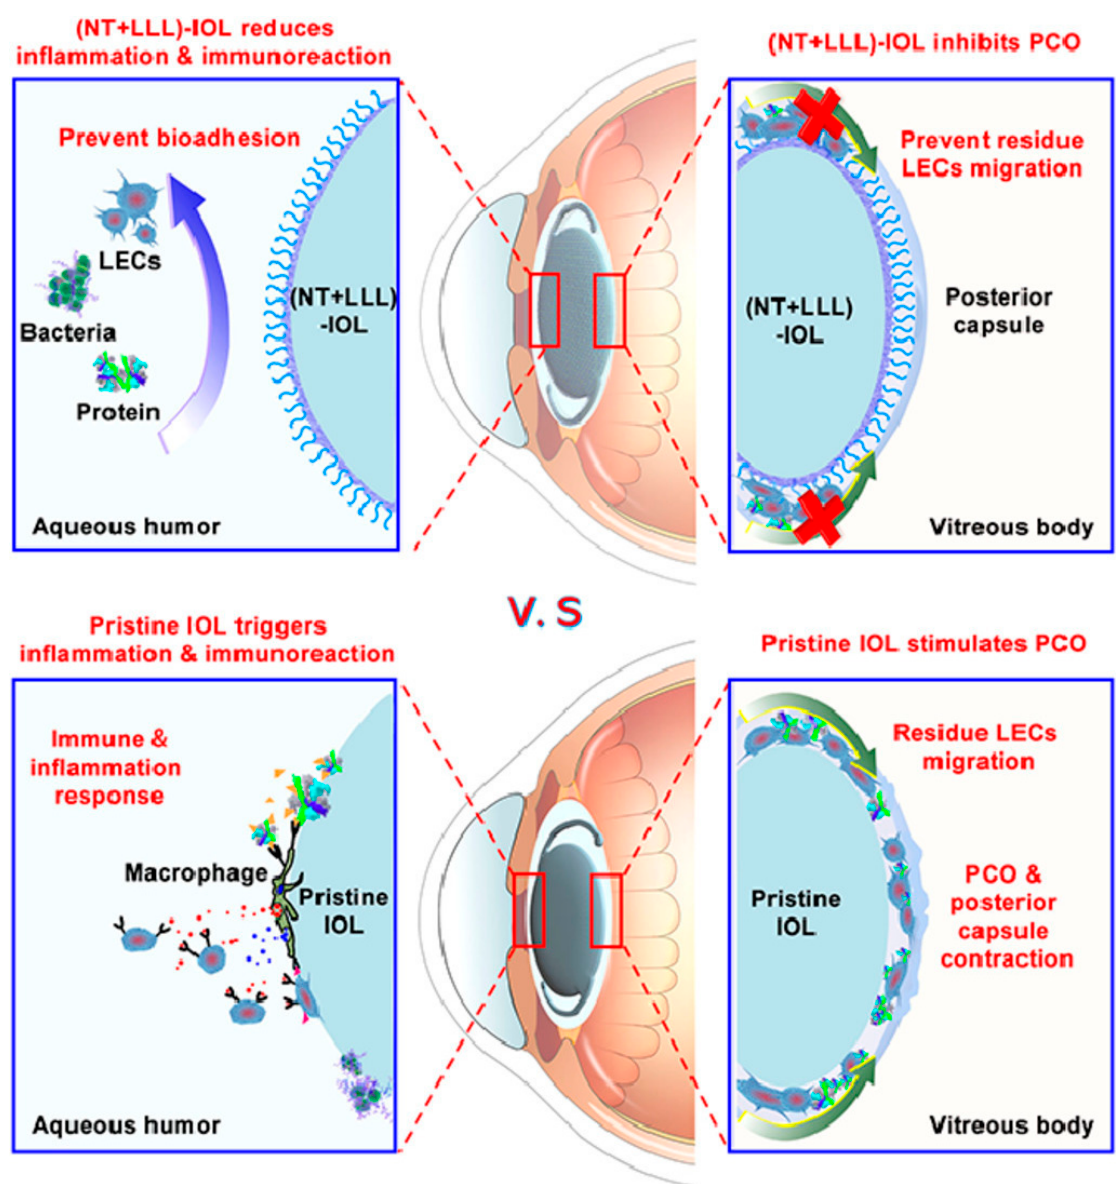
Figure 3. Schematic illustration of the (NT + LLL)-IOL with advantages of anti-bio-adhesion and PCO inhibition, compared to the pristine IOL. Adapted with permission from Ref. [43]. Copyright 2021 Elsevier.